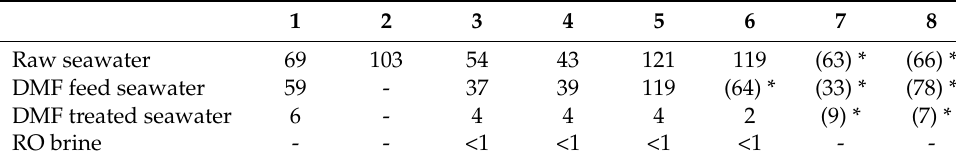
Figure 13. Results of Biofilm development. Table 6. Results of mBFR